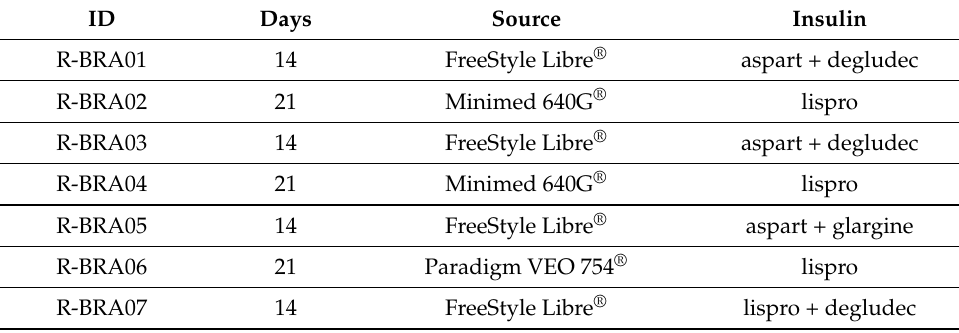
Table 4. Satellite characteristics used to collect data.